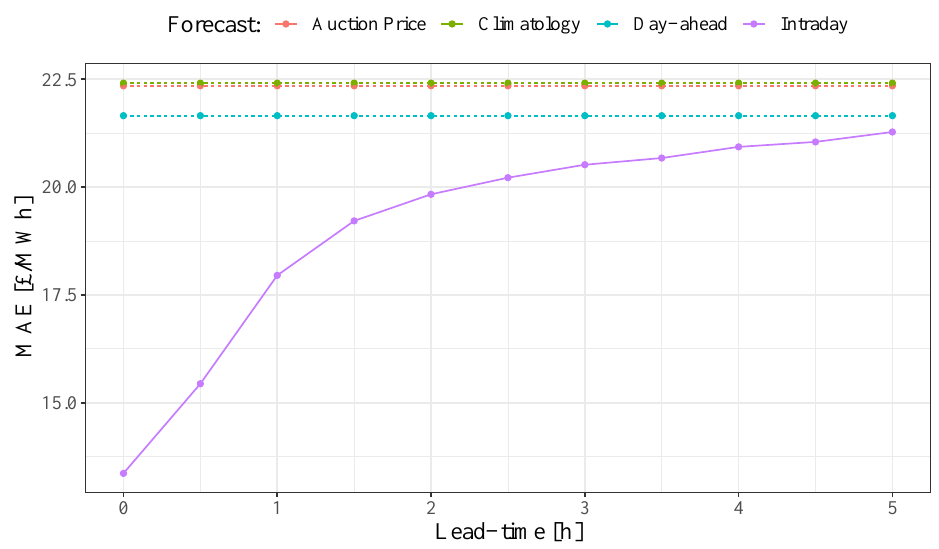
Figure 2. Point forecast performance in terms of Mean Absolute Error (MAE) by lead-time (solid lines). Day-ahead forecasts (dashed lines) are issued once per day over 12 h in advance and do not change intraday—hence there is no change in MAE by